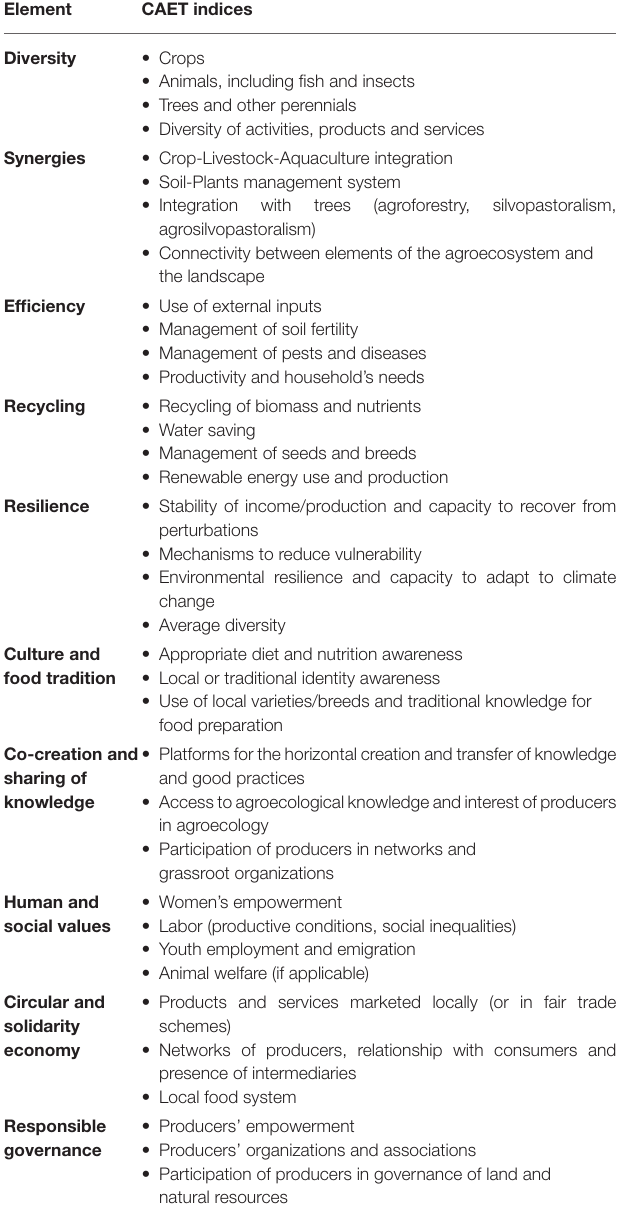
TABLE 3 | Indices used for each of the 10 Elements of